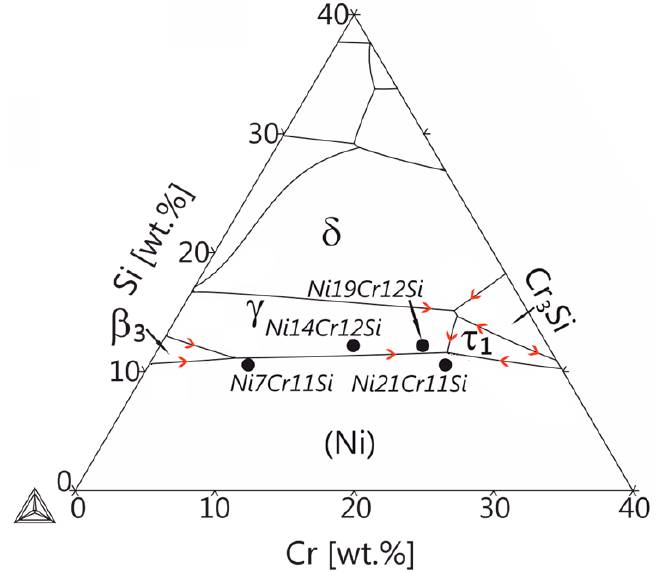
Figure 1. Liquidus projection of the ternary Ni-Cr-Si system at the Ni-rich corner. Thermodynamic database TCNi5 was used for calculations. Four alloys marked by black solid circles were selected for this study.